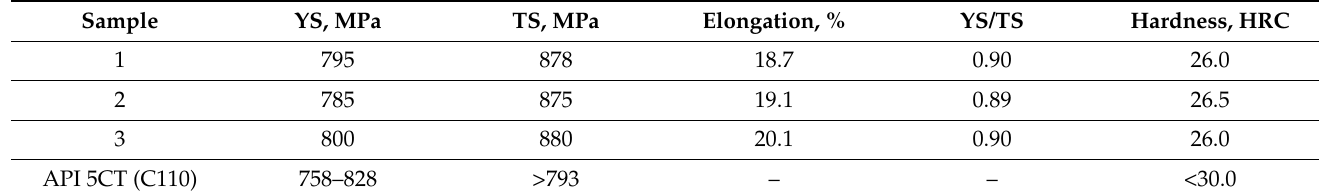
Table 1. Mechanical properties of the OCTG samples.